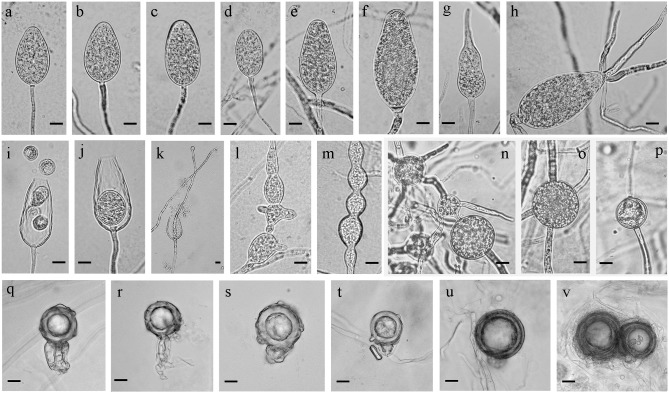
Morphology of Phytophthora ×stagnum.(a–g) Nonpapillate and noncaducous sporangia in various shapes; (a, b) Ovoid sporangia; (c, d) Ovoid to ellipsoid sporangia; (e, f) Obpyriform sporangia; (g) A germinated sporangium in distorted shape; (h) Direct germination of an obpyriform sporangium; (i) A sporangium releasing zoospores; (j) Nested internal proliferation; (k) Extended internal proliferation; (l) Hyphal swellings; (m) Catenulate hyphal swellings; (n) Thin-walled intercalary chlamydospores and hyphal swellings; (o) A thin-walled intercalary chlamydospore; (p) A thick-walled chlamydospore; (q–t) Ornamented, aborted oogonia produced by isolates 36H8 and 36J7; (q) An oogonium with an amphigynous antheridium; (r–t) Ornamented oogonia with distorted antheridia; (u, v) Relatively smooth-walled, darkly pigmented oogonia produced by isolates 43F3 and 44F9; (u) An oogonium containing a plerotic oospore with a globose antheridium; (v) Oogonia with abortive oospores. Bars = 10 µm.